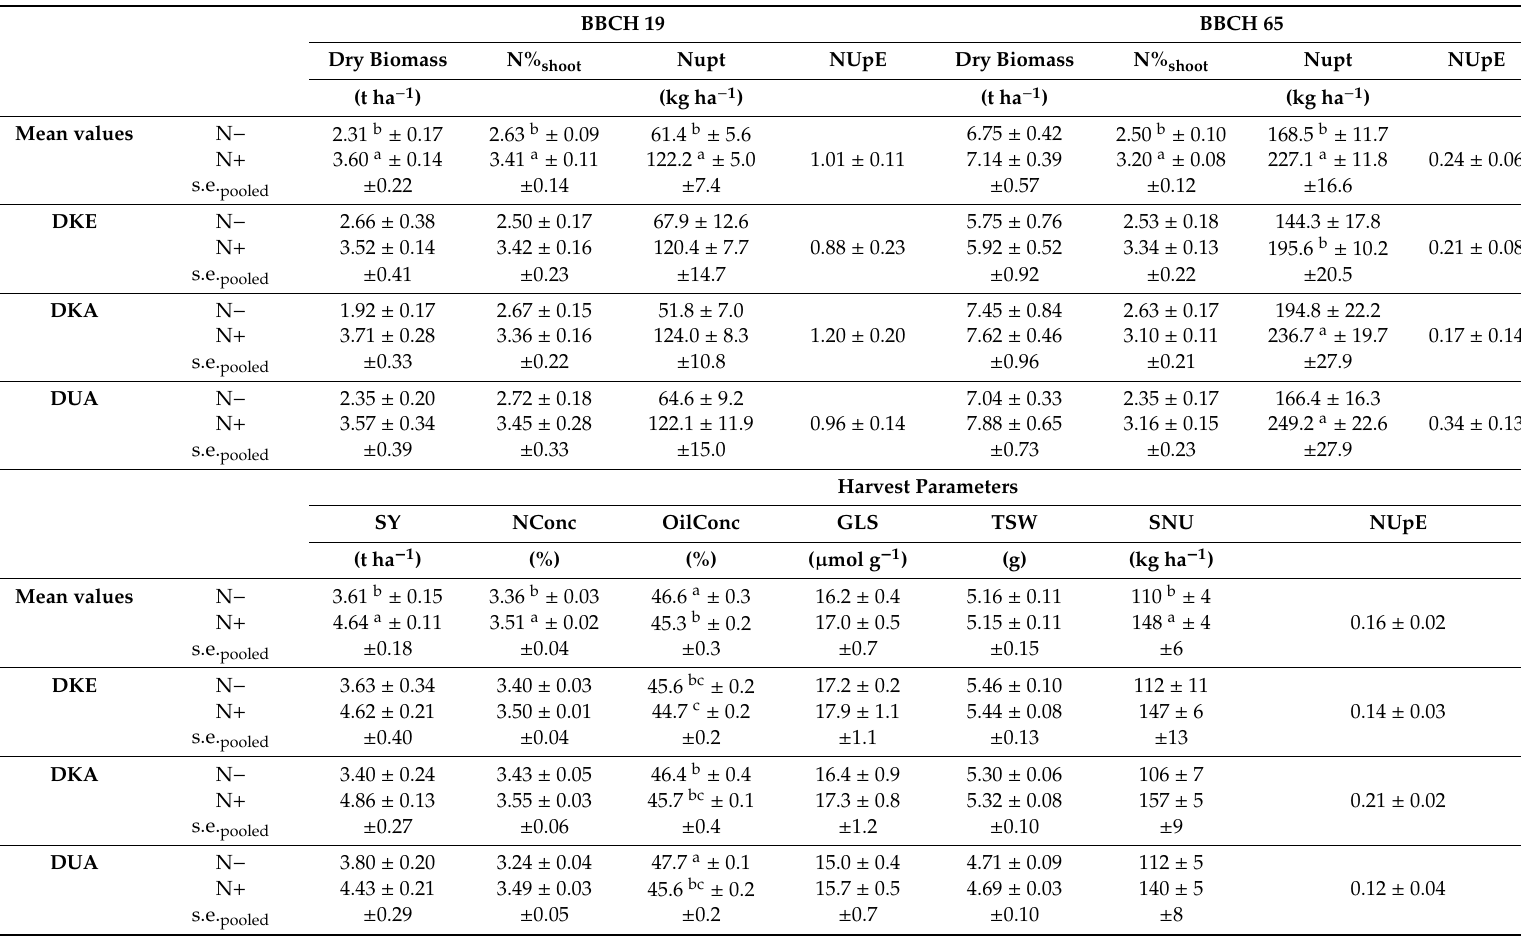
Table 2. Above-ground biomass measurements and harvest parameters. Mean values according to the fertilizer treatments (n = 12 ± s.e.) and to individual cultivars (n = 4 ± s.e). Letters indicate statistical di ff erences at significance level α = 0.05. Pooled standard errors (s.e.